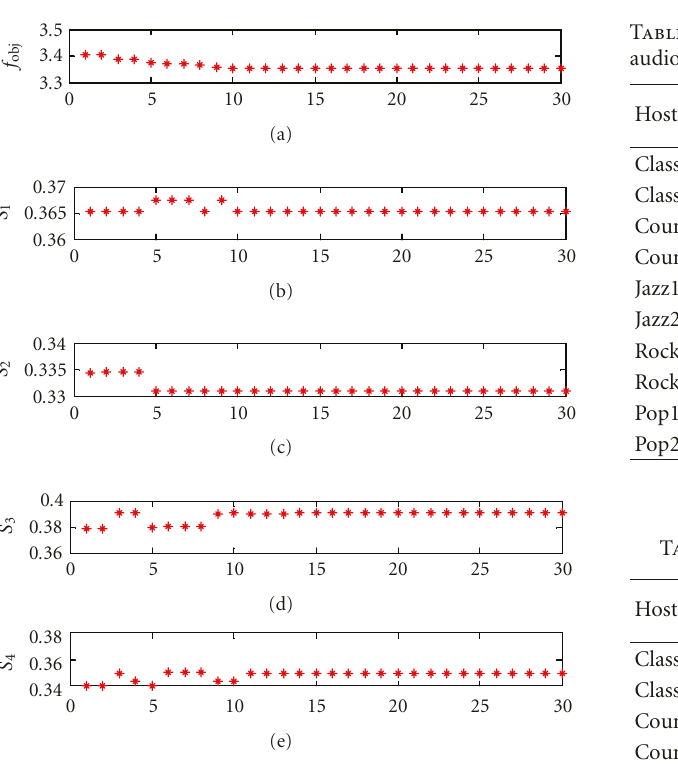
Figure 8: f obj , S 1 , S 2 , S 3 , and S 4 from GA optimization process (Classical1).